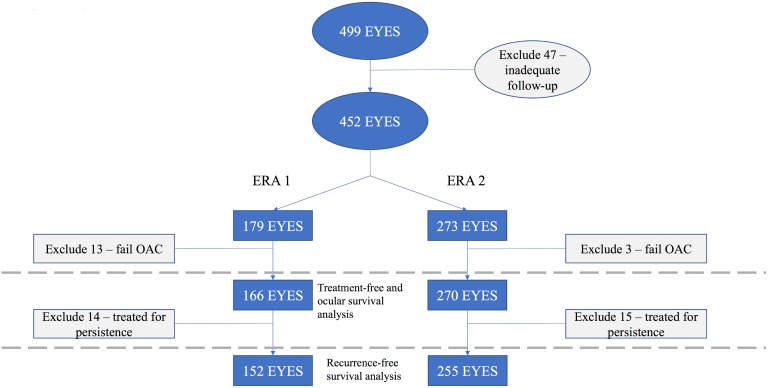
Eyes included in analyses.